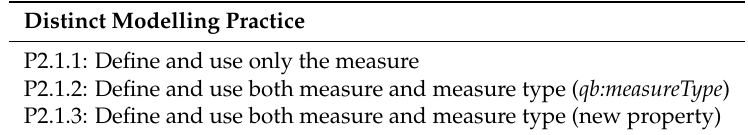
Table 19. Distinct modelling practices of data portals for the measure and its parameters.